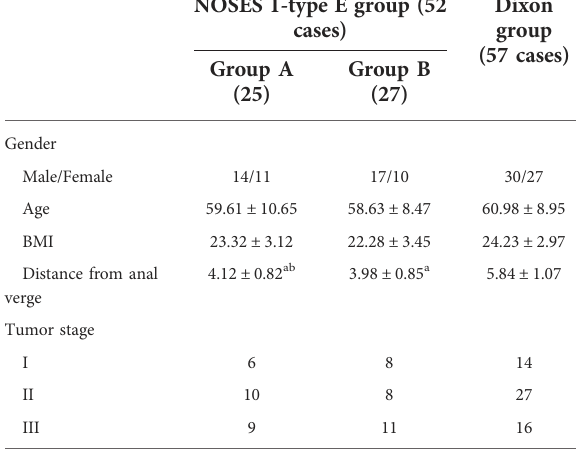
TABLE 3 Comparison of postoperative complication indicators NOSES I-type E group (52 cases)